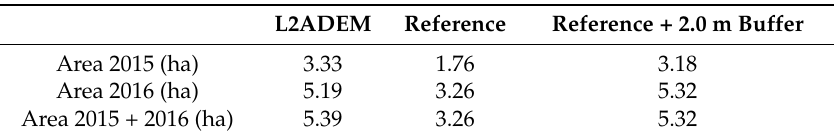
Table 12. Evaluated area from time series on OS2.